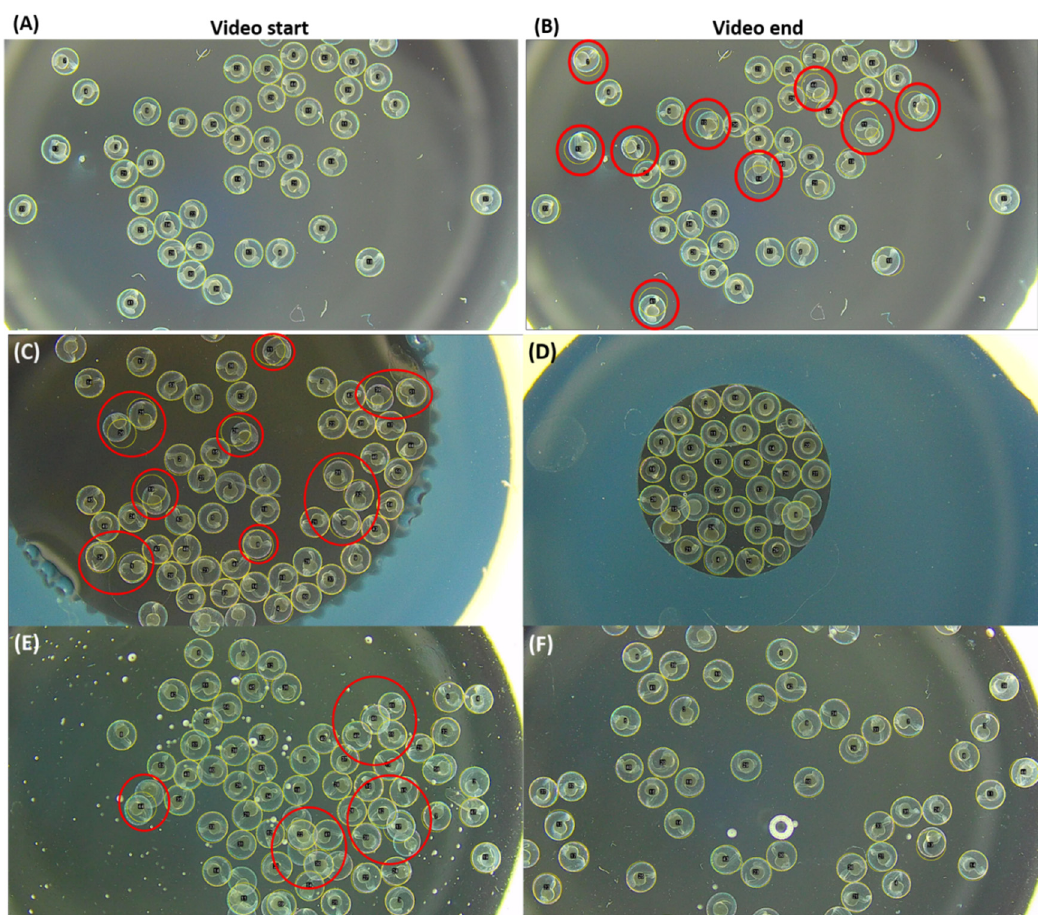
Figure 3. Comparison of different methods to reduce embryo position shifting during video recording for tail coiling measurement in zebrafish. ( A ) ROI selection in dissecting microscopy with darkfield setting. ( B ) Some embryos’ position was shifted due to embryo tail coiling (labeled by red circles). Two different sizes of agarose holders were tested to reduce the inter-embryo space with either ( C ) agarose outer wall (ø = 8.5 mm) or ( D ) agarose outer wall (ø = 4.4 mm). Two different concentrations of methylcellulose at either ( E ) 1% or ( F ) 0.5% were used to increase the mounting medium viscosity to prevent embryo position shifting. Egg movement caused by tail coiling occurrence was detected and marked with red circles. Images were captured at a low magnification at 6 ×